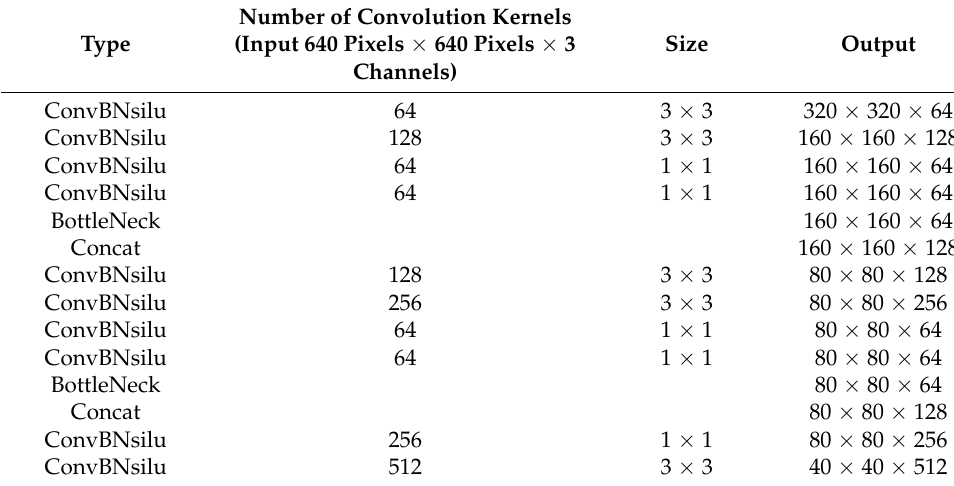
Table 2. Network backbone hierarchy.